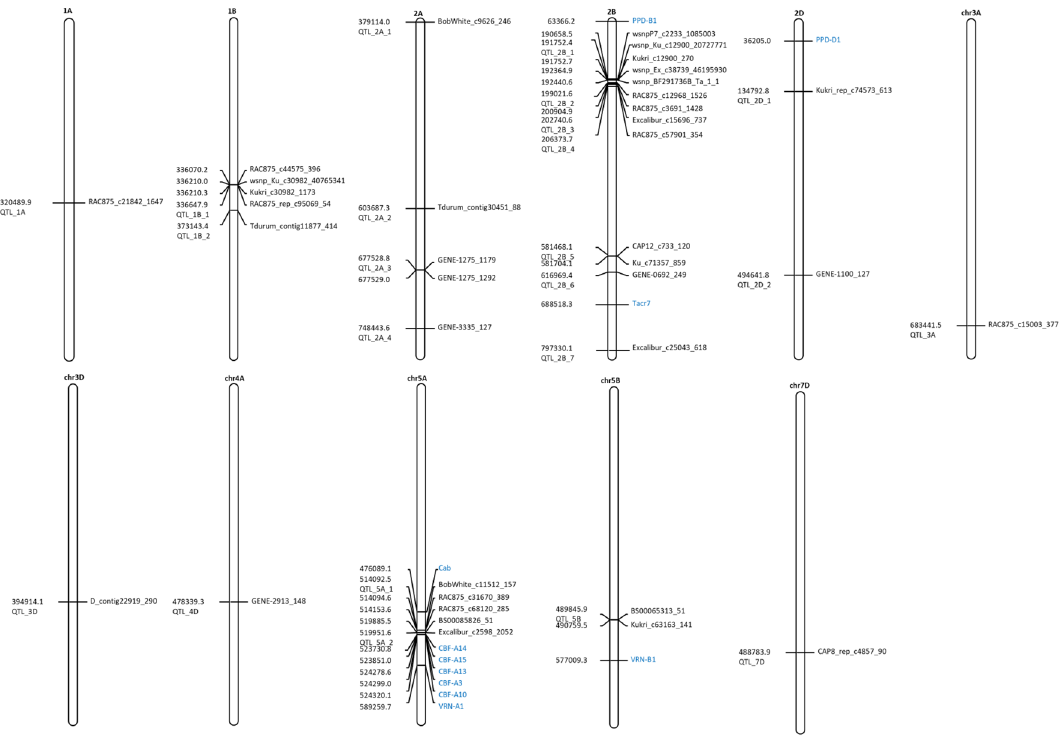
Figure 1. Genetic map of identified QTLs for FroT on wheat chromosomes: the identified markers are shown on the different chromosomes. Eleven candidate genes analysed by Babben et al. 25 are assigned with blue